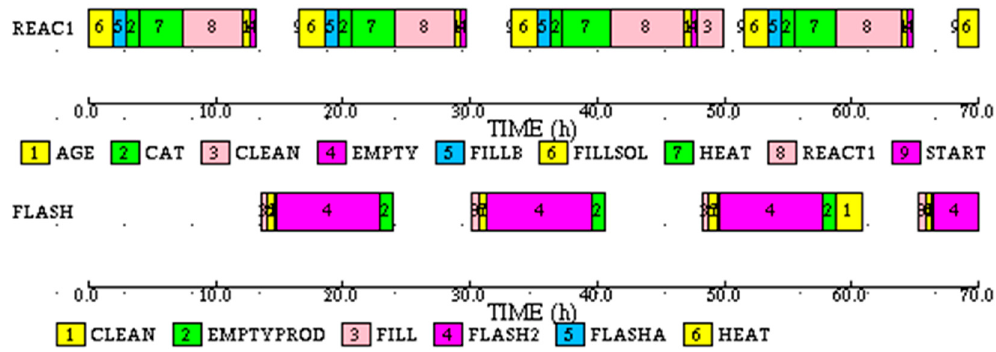
Figure 20. Subtask Gantt chart for REAC1 and FLASH for the specialty chemical process.